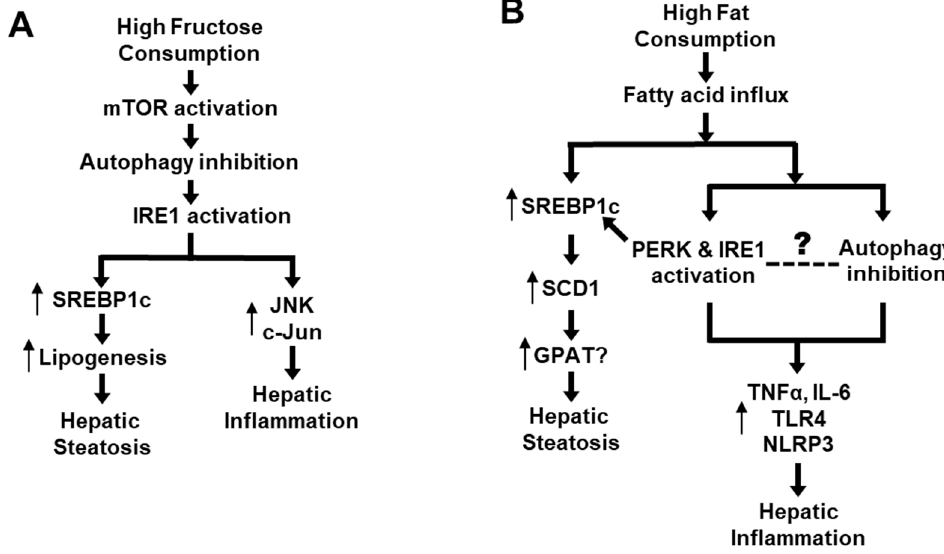
Figure 2. Proposed role of an autophagy-ER stress axis in the pathogenesis of NAFLD. ( A ) Mechanism of high intake of fructose-induced NAFLD via the autophagy-ER stress based on [7,29,31,37–39,45]. ( B ) Mechanism of high-fat diet-induced NAFLD via the autophagy-ER stress based on [9,29,31,39,44,46,51–54].